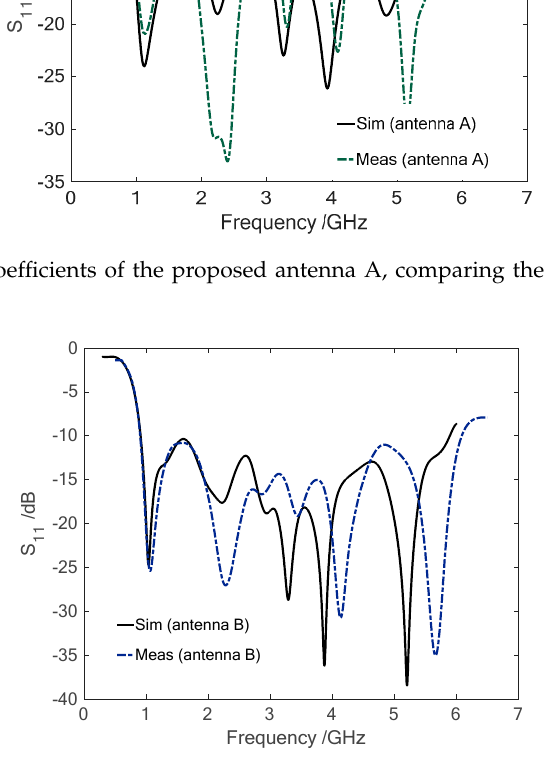
Figure 9. Reflection coefficients of the proposed antenna A, comparing the measured result with the simulation.